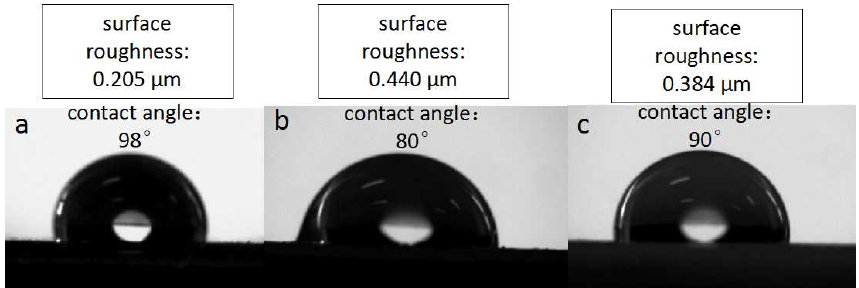
Figure 10. The roughness data and picture of contact angle of ( a ) pure epoxy coating, ( b ) OTiO 2 (w) epoxy coating, and ( c ) iETiO 2 (w) epoxy coating. epoxy coating, and ( c ) iETiO 2 (w) epoxy